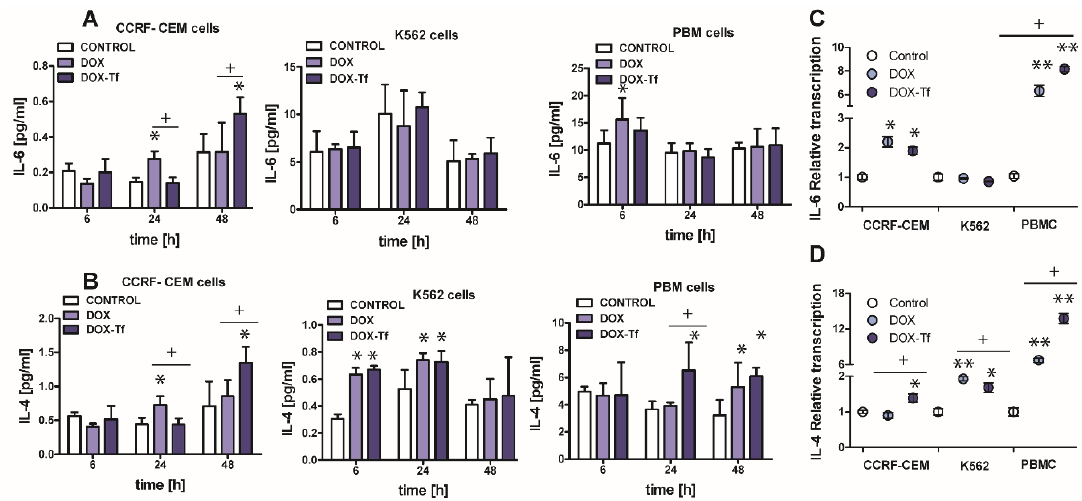
Figure 6. The evaluation of pro-inflammatory cytokines level after leukemia cells treatment with DOX and DOX–Tf conjugate. ( A , B ): The concentrations of interleukin 4 (IL-4) and interleukin 6 (IL-6) secreted in the supernatants of CCRF-CEM, K562, and PBMC cultures treated with IC 50 concentrations of doxorubicin–transferrin (DOX–Tf) conjugate and DOX alone for 6, 24, or 48 h. The results show mean ± SD of three independent experiments. * p < 0.05,in comparison to untreated, control cells, ( + ) statistically significant di ff erences observed between the probes incubated with free DOX in comparison to the conjugate, + p < 0.05. ( C , D ): Level of mRNA transcripts for IL-6 and IL-4 genes in CCRF-CEM, K562, and PBMCs exposed to IC 50 concentrations of DOX–Tf conjugate and free doxorubicin for 48 h. Data ( ∆∆ Ct values) were transformed into relative copy number values (the number of mRNA copies of the examined genes per housekeeping gene index, calculated as the average Ct value of the HPRT1 and HMBS housekeeping genes) and standardized to the level of mRNA transcripts in untreated cells, taken as 1. Results are presented as the means ± SD, ( n = 6). Asterisks refer to the level of significant di ff erence (* p < 0.05, ** p < 0.01) in mRNA level in the drug treated cells compared to untreated cells (control), whereas—symbol “ + ” ( + p < 0.05) refers to statistically significant di ff erences between the cells incubated with DOX–Tf conjugate in comparison to the cells incubated with a reference drug (free